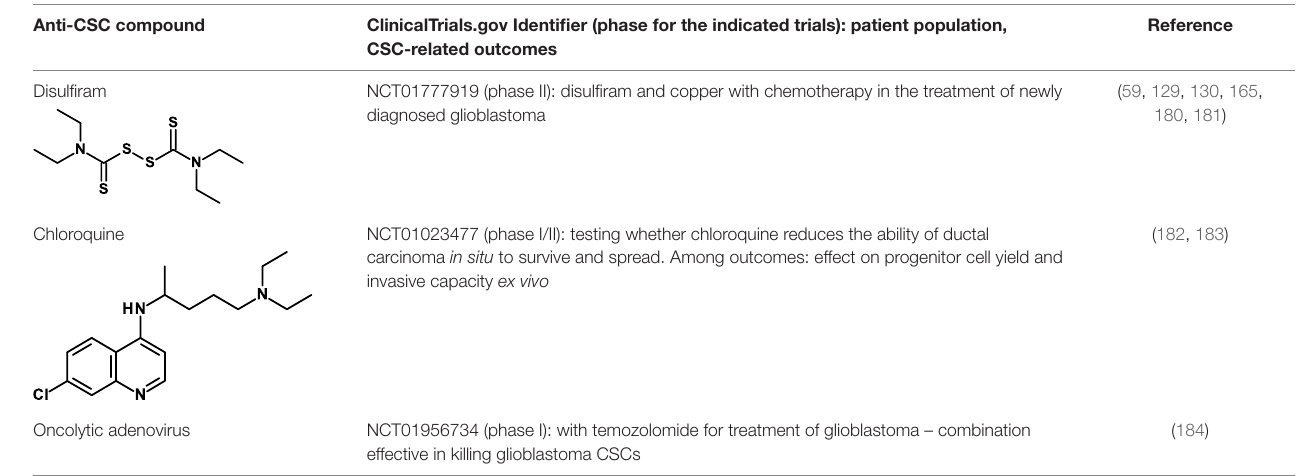
TABLe 5 | Anti-CSC compounds with undefined mechanism of action or targeting diverse signaling pathways. Anti-CSC